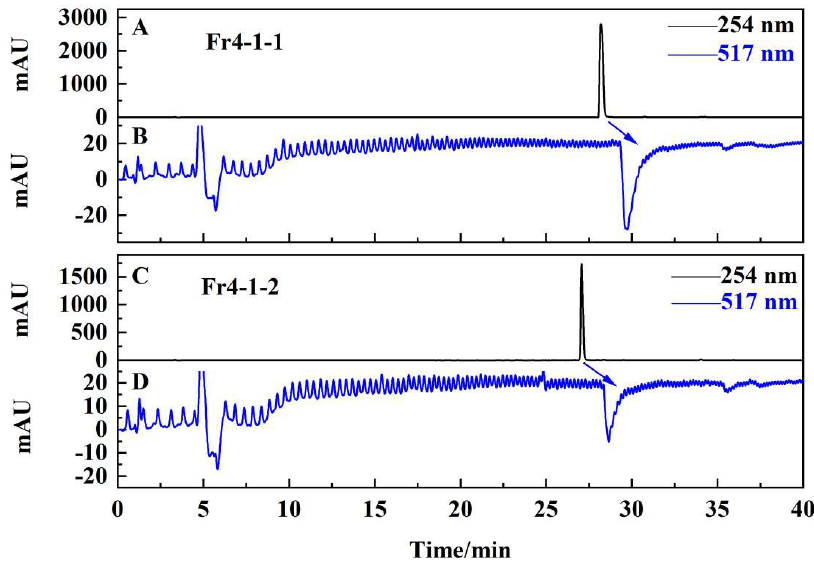
Figure 5. Purity and DPPH inhibitory activity verification chromatograms of the isolated Fr4-1-1 ( A , B ), Fr4-1-2 ( C , D ), with the Dubhe C18 analytical column.